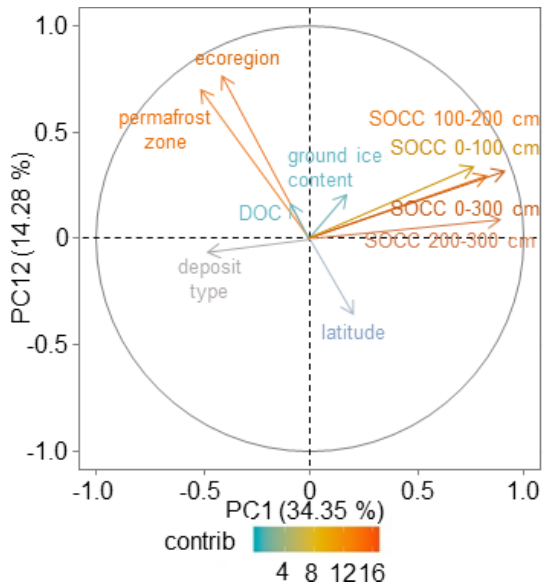
Figure A2. Principal component analysis showing a variable factor map with a color gradient showing the contribution to the plane construction. The first two principal components explained 34.35% (PC1) and 14.28% (PC2) of the variance in the analyzed parameters (DOC, latitude, permafrost zone, ecoregion, ground ice content, deposit type, SOCC). The scores of PC1 had positive loadings with SOCC at all depths and negative loadings with deposit type, while PC2 scores had negative scores of latitude and positive scores of DOC, permafrost zone, ecoregion, and ground ice